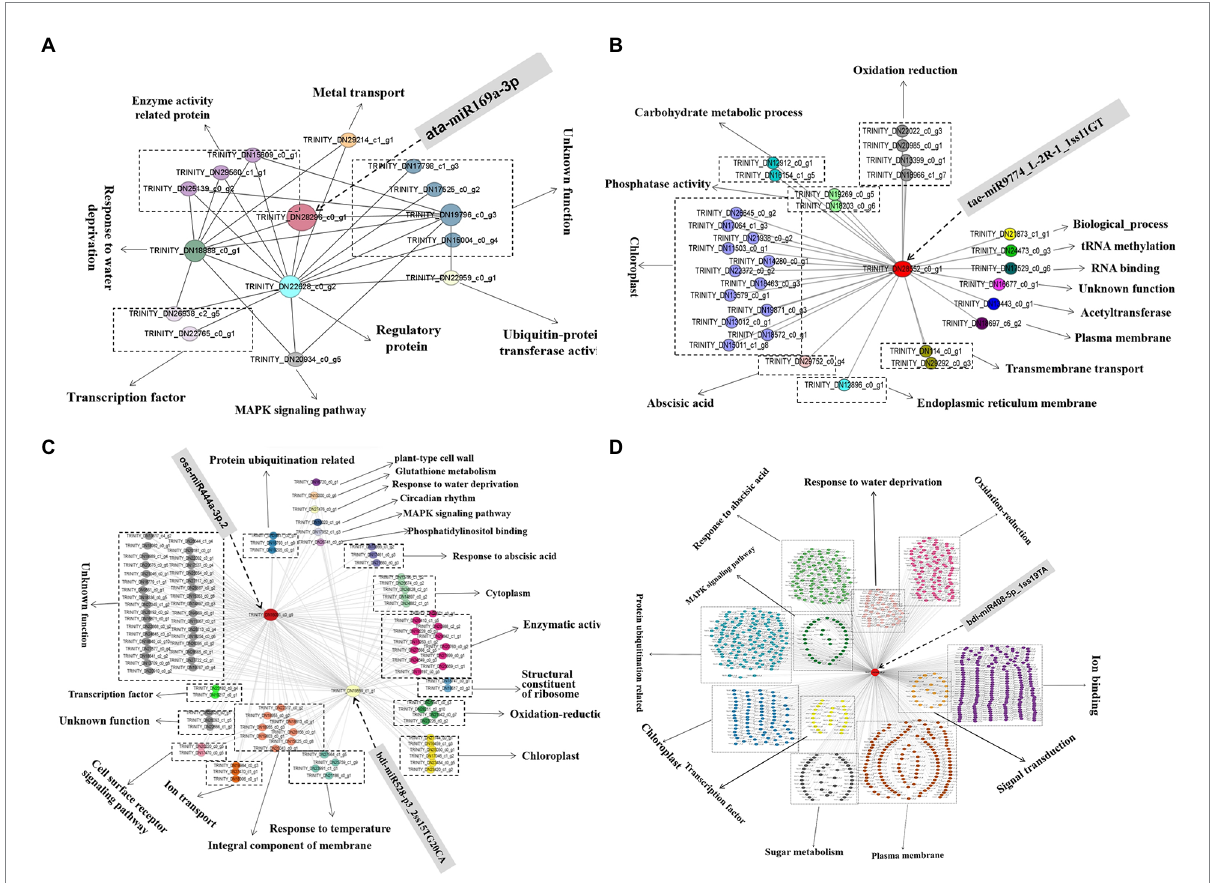
FIGURE 8 The coexpression subnetwork of five hub genes. Red-colored nodes suggest their central role in the network, and other nodes of the same color indicate the same function. (A) , (B) , (C) , and (D) represent the coexpression subnetwork of TRINITY_DN28296_c0_g1 ( PAO2 ), TRINITY_ DN28552_ c0_g1 ( carC ), TRINITY_DN16091_c0_g9 (MADS47), TRINITY_DN19559_c1 _g1 ( HOX24 ), and TRINITY_DN29080_c0_g1 ( CCX1 ), respectively. A part of the gene ID corresponds to the gene name: Os06g0107700 (TRINITY_DN22022_c0_g3), XB3 (TRINITY_DN22959_c0_g1), CLPC1 (TRINITY_DN21467_c0_g3), and BPM2